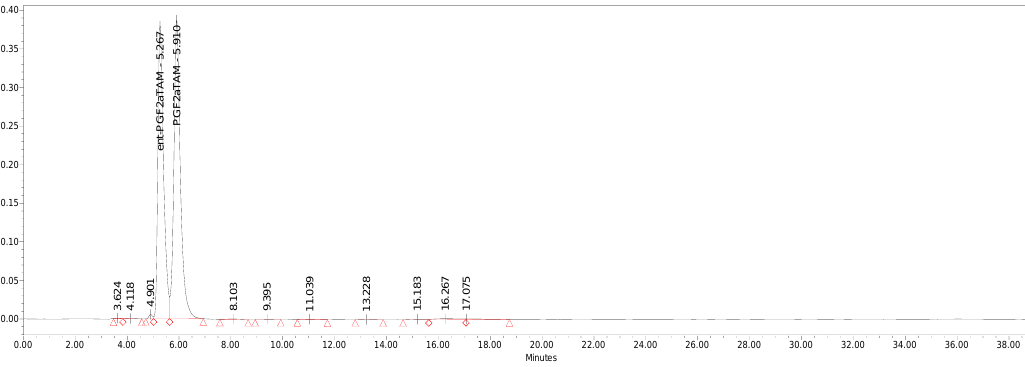
Figure 2. Chiral separation of the optical isomers of PGF 2α (tested as TAM salt), R = 1.5. Optimized parameters: Eluent: MeCN:MeOH:water (pH = 4) = 30:10:60, column temperature 25 °C, wavelength 200 nm.